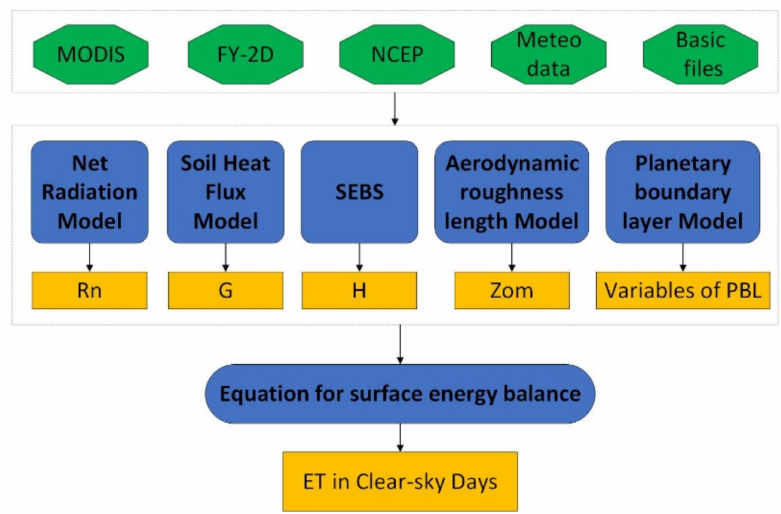
Figure 3. Estimation flowchart for ET on cloud-free days. The green indicates input data, the blue indicates methods, the orange indicates